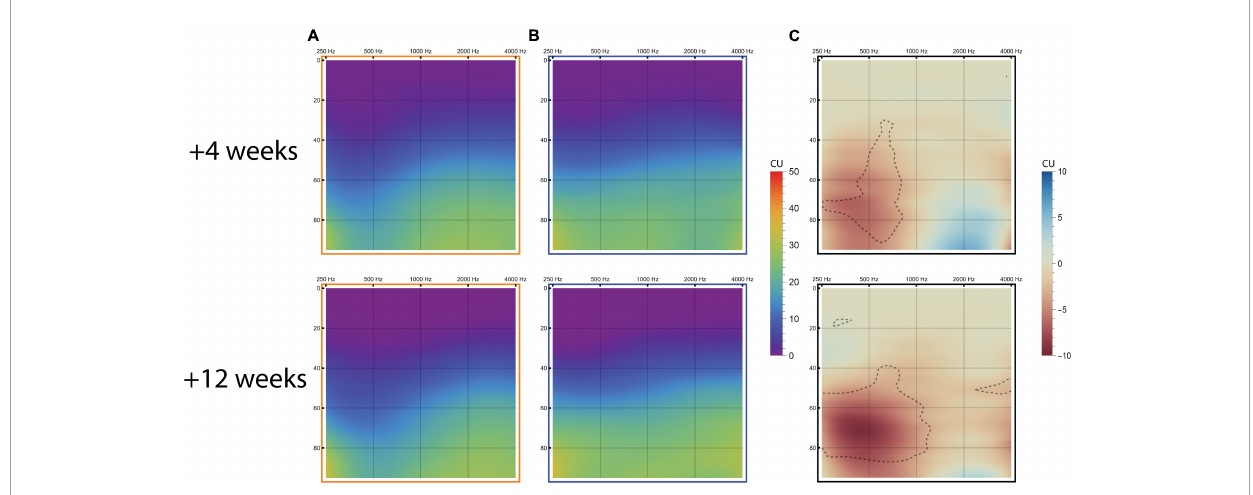
FIGURE10 Loudness growth measured with the ACALOS scaling procedure. Results are visualized in loudness audiograms for the imaging-based fitting (A) , standard fitting (B) , and imaging-based minus standard fitting [ (C) ; red colors resemble more loudness with standard fitting, blue colors indicate more loudness with imaging-based fitting with delineated regions indicating significant differences after Holm-Bonferroni correction]. The graphs display loudness growth with x-axis = frequency (Hz), y-axis = stimulus intensity level (dB HL) and loudness perception (CU) color-coded according to legend.